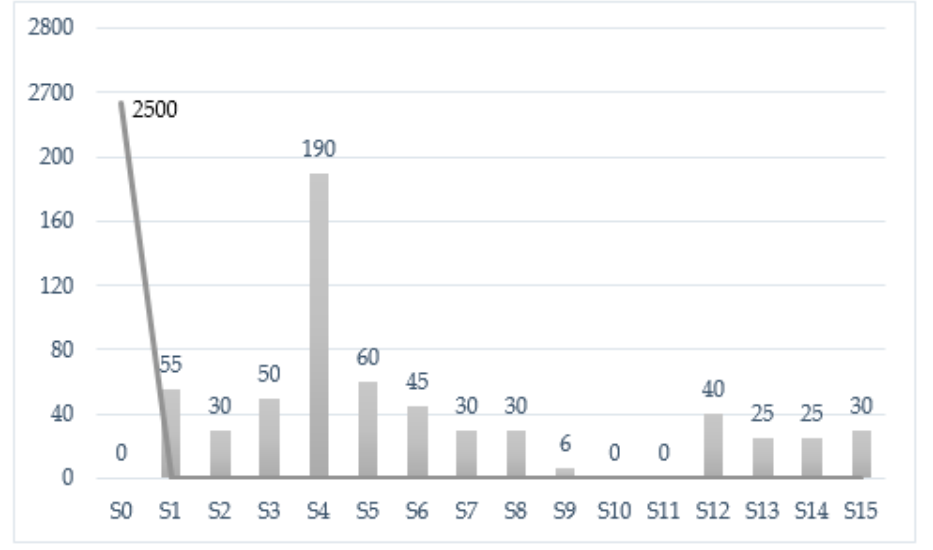
Figure 11. Electromagnetic wave power density for C 1 to S 0 , S 1 , …, and S 15 .